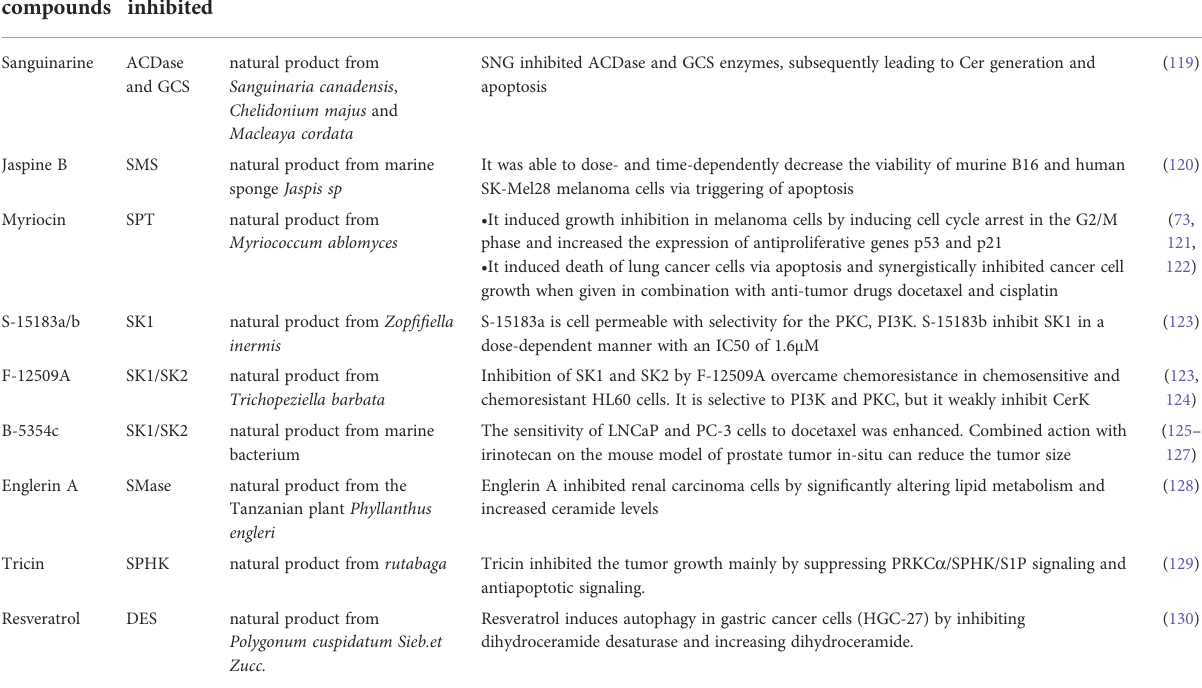
TABLE 3 Summary of anticancer therapies of Natural compounds. Natural Targets compounds